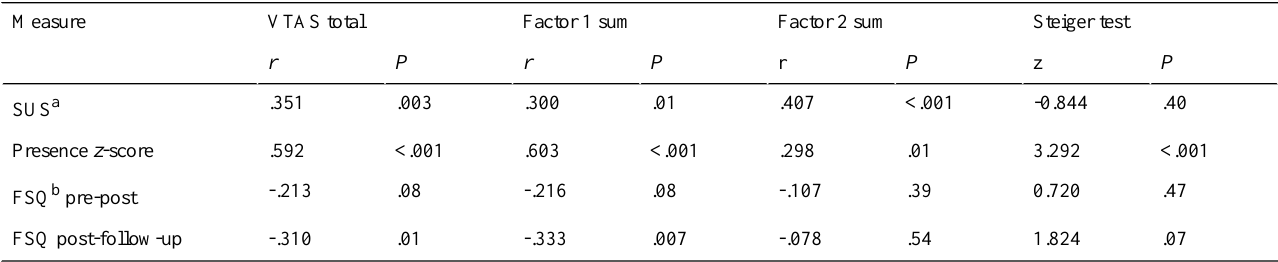
Table 2. Correlations table between Virtual Therapist Alliance Scale (VTAS) total and factor sum scores as compared to process measures, outcome difference scores, and Steiger test conducted between factor